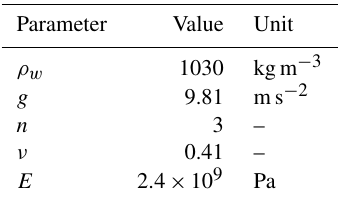
Table 2. List of model parameter choices for the default model